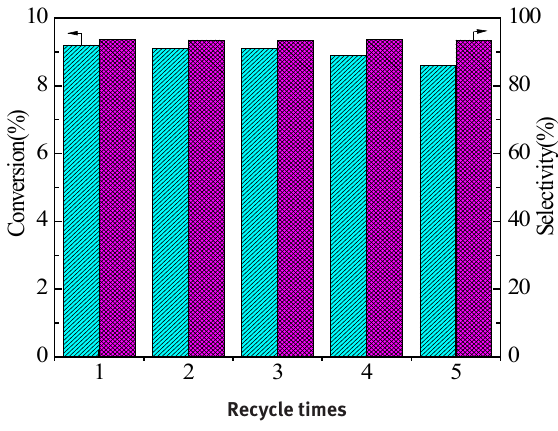
mimHSO -Co/ZSM-5 catalyst 7 4 (1.5MPa), 150 o C, 2